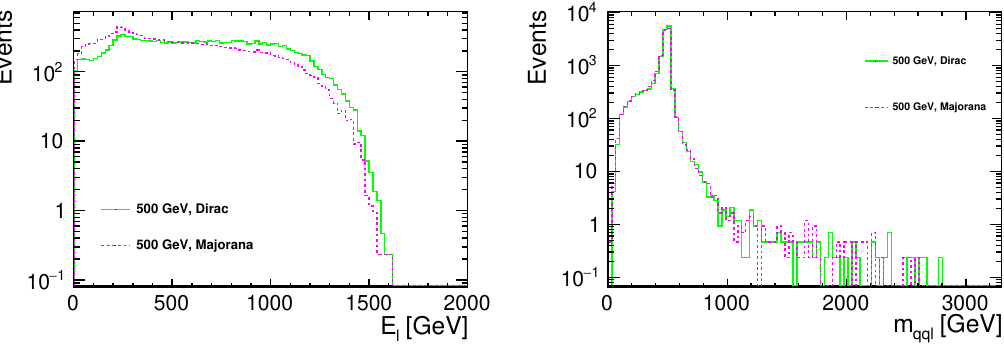
Figure 11. Distributions of the E ‘ (left) and m qq‘ (right) for the Majorana (pink dashed line) and the Dirac (green solid line) neutrinos with a mass of 500 GeV at CLIC3000 (detector simulation